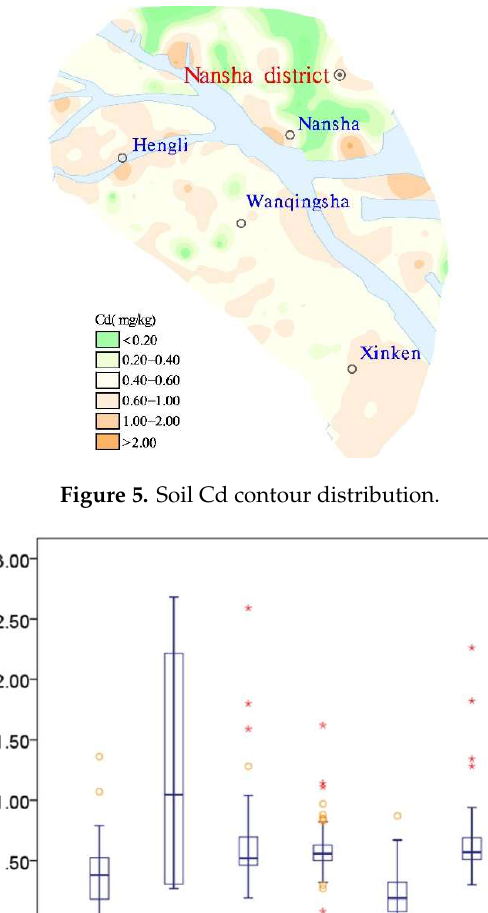
Figure 6. Box charts for Cd content of the different soil types.